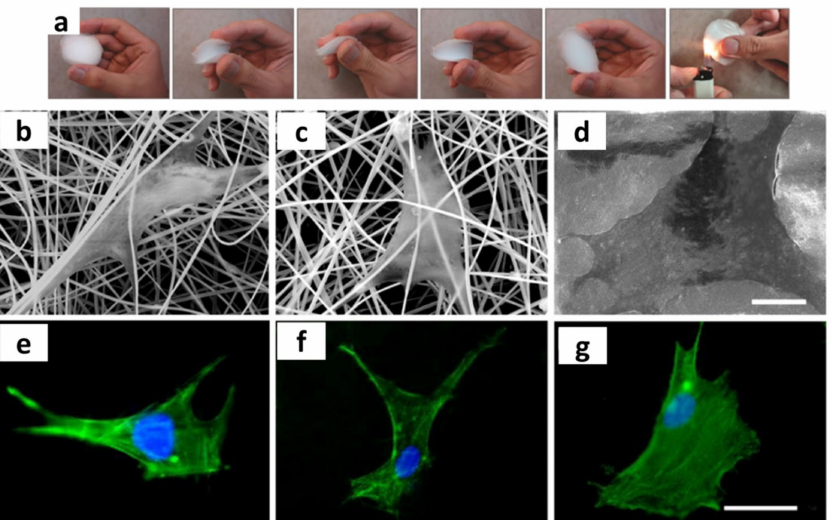
Figure 13. ( a ) Flexibility of YSZ nanofiber mats. Characterisation of the cell morphology and actin cytoskeleton organisation of hMSCs after 3 d of culturing in BM. Representative SEM images of hMSCs on ( b ) microwave-annealed (MW 5 ◦ C/min) nanofiber scaffolds, ( c ) conventional oven- annealed (CO 5 ◦ C/min) nanofiber scaffolds and ( d ) YSZ bulk disk scaffolds. Representative images of actin cytoskeleton organisation of hMSCs on ( e ) microwave-annealed (MW 5 ◦ C/min) scaffolds, ( f ) conventional oven-annealed (CO 5 ◦ C/min) scaffolds and ( g ) YSZ bulk disk scaffolds (actin filaments labelled with phalloidin are shown in green, and nuclei labelled with DAPI are shown in blue). Images used from Gazquez et al. [97], reprinted with permission from ACS, copyright©